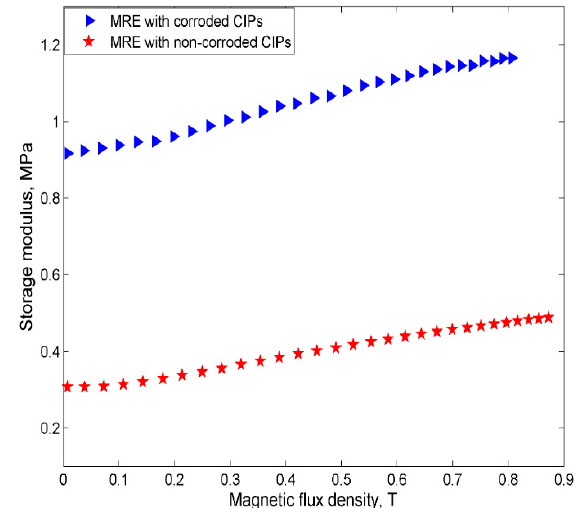
Figure 13. The storage modulus of the MRE samples of non-corroded and corroded CIPs vs. magnetic flux densities.